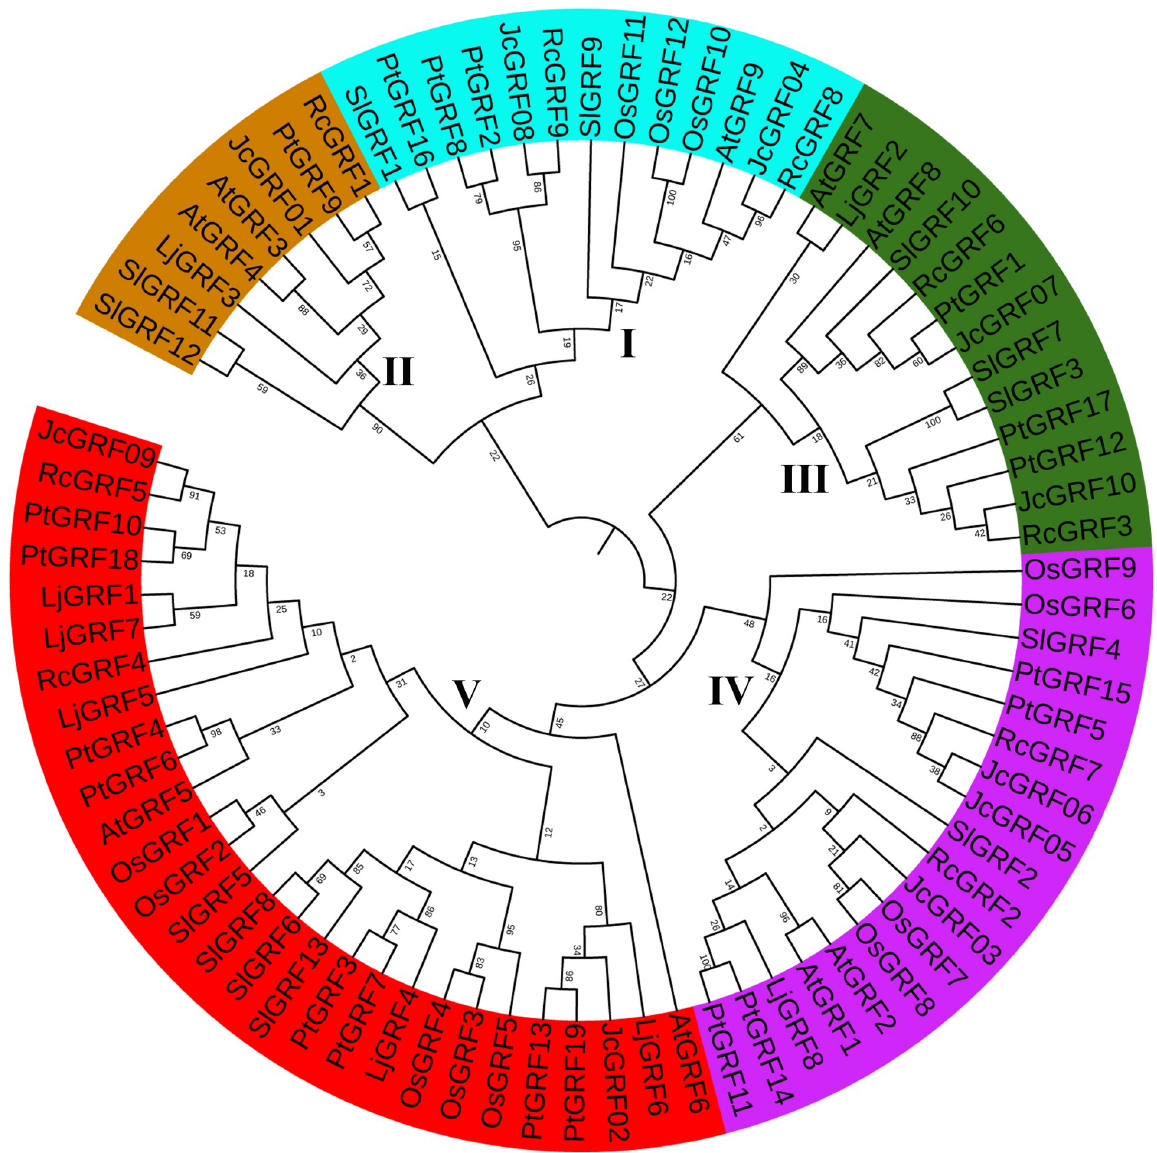
Fig 1. Phylogenetic tree of GRF protein. The NJ method (1000 bootstraps) was used to create the phylogenetic tree based on the similarity of full-length amino acid sequences of GRF proteins from physic nut, Arabidopsis , rice, castor bean, tomato, Lotus japonicus and poplar.